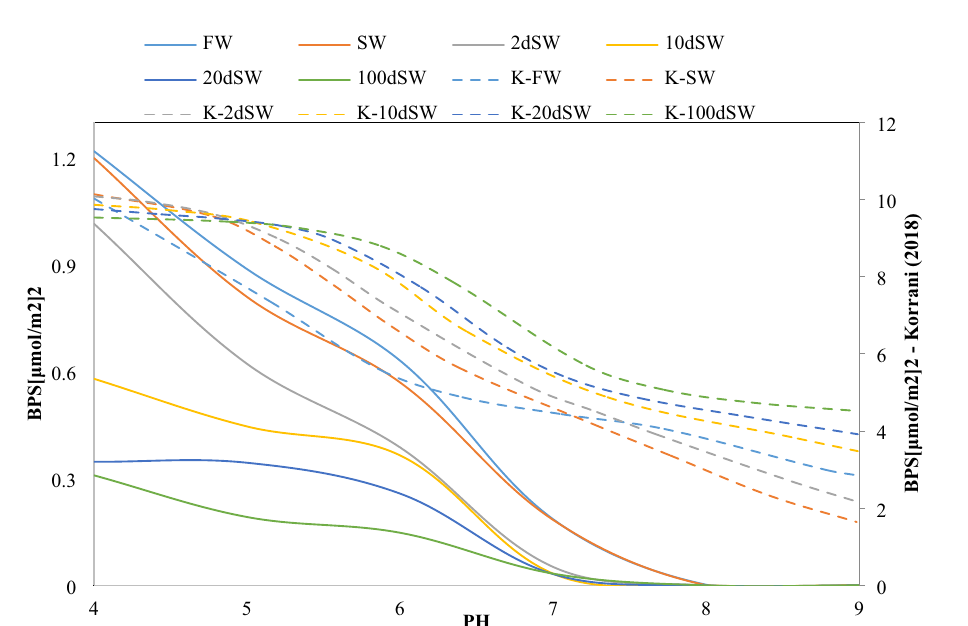
Figure 6. Calculated BPS for brines used in Yousef et al . 51 ’s core flood using the developed model compared to BPS values extracted from Korrani 53 , axes on right and dashed line on legend are data extracted from Korrani 53 ’s work, solid lines are data calculated using the developed